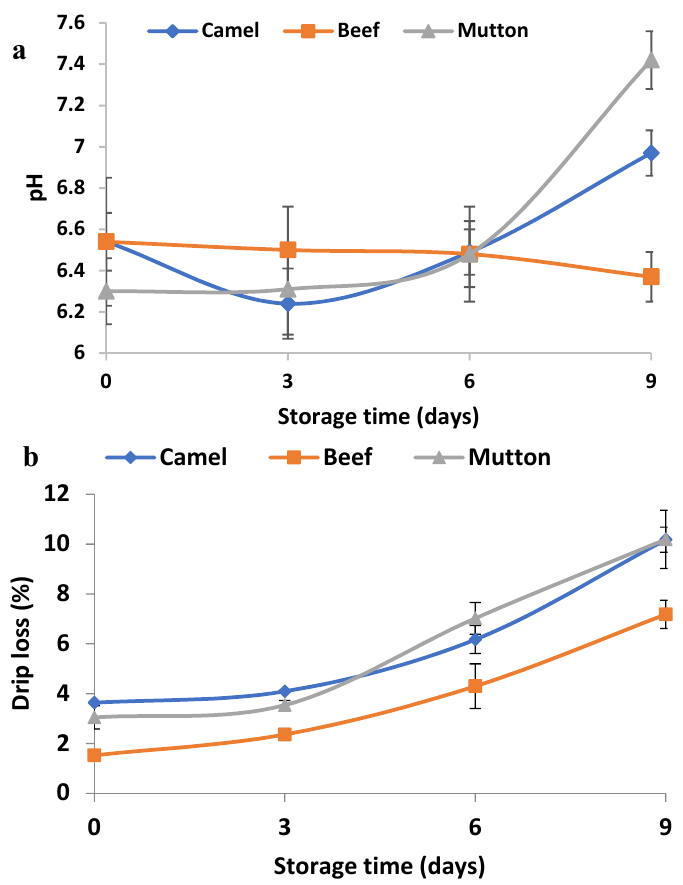
Figure 1. Changes in pH ( a ) and drip loss (%) ( b ) in camel meat, beef and mutton over 9 days of refrigerated storage. Data are represented as mean ± SEM ( n = 6).